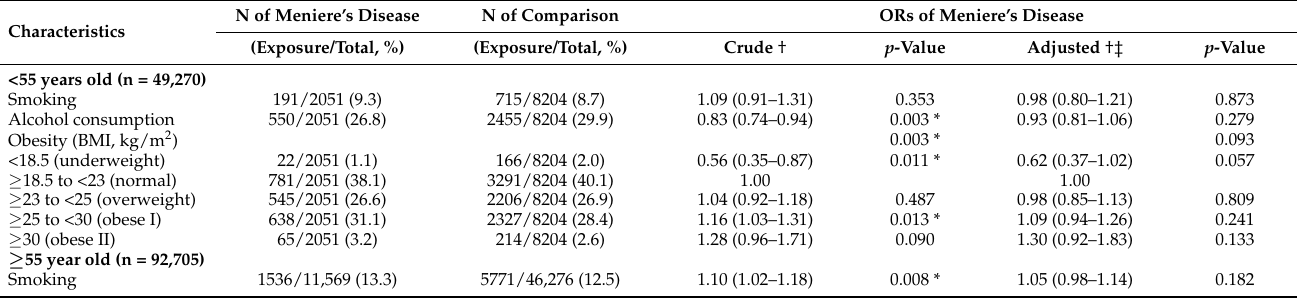
Table 3. Crude and adjusted odd ratios (95% confidence interval) of smoking, alcohol consumption, and obesity for Meniere’s disease in each stratified group according to age and sex. * Conditional logistic regression analysis, significance at p < 0.05. † Stratified model for age, sex, income, and region of residence. ‡ Adjusted model for Charlson comorbidity index, obesity, smoking state (current smoker compared to a non-smoker or past smoker), frequency of alcohol consumption ( ≥ 1 time a week compared to <1 time a week), SBP, DBP, fasting blood glucose, total cholesterol, dyslipidemia, benign paroxysmal vertigo, vestibular neuronitis, and other peripheral vertigo. BMI: body mass